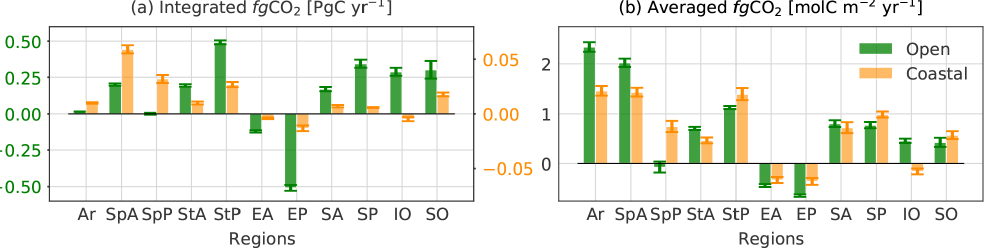
Figure 6. Distribution of contemporary fluxes (positive into the ocean) over 11 regions (see in Fig. 2) for the full period 1985–2019. Uncertainties in the mean estimates of air–sea fluxes integrated (a) or averaged (b) over each region are shown with error